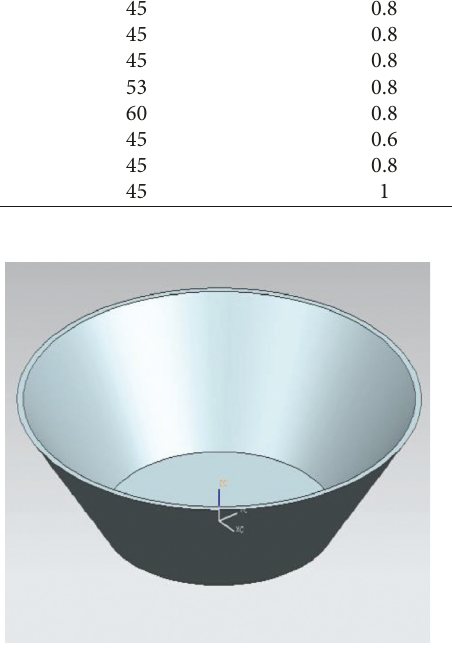
Figure 5: Target